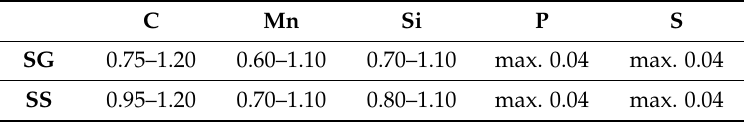
Table 2. Chemical composition of steel shot in wt. %.